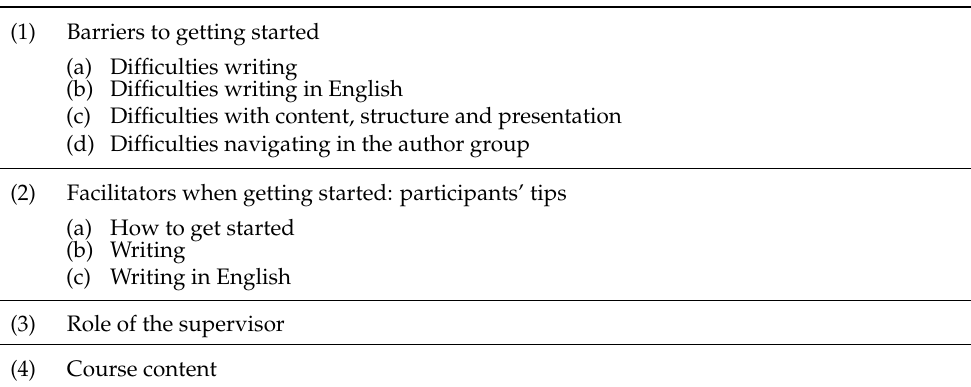
Table 2. Themes and subthemes of interviews about writing the first